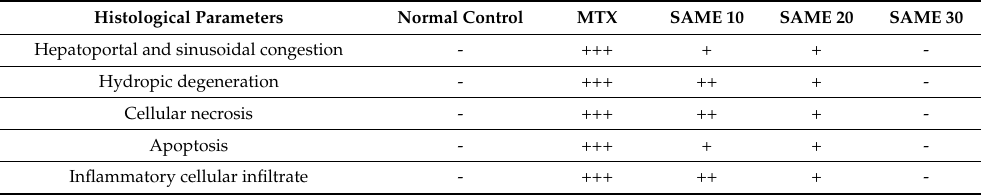
Table 5. Semi-quantitative scoring shows the hepatoprotective effects of SAME. Histological Parameters Normal Control MTX SAME 10 SAME 20 SAME 30 Hepatoportal and sinusoidal congestion - +++ - Hydropic degeneration - - Cellular necrosis Apoptosis Inflammatory cellular infiltrate -